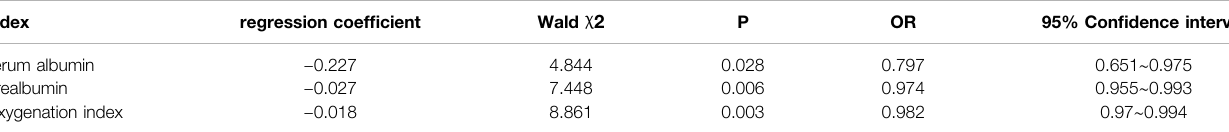
TABLE 4 | Multivariate logistic regression analysis of covid-19 clinical screening.